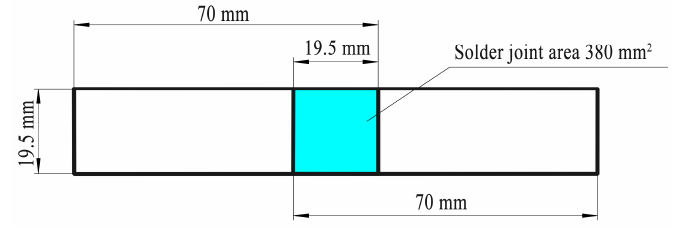
Figure 3. The lap joint diagram of vacuum diffusion welding (VDW).